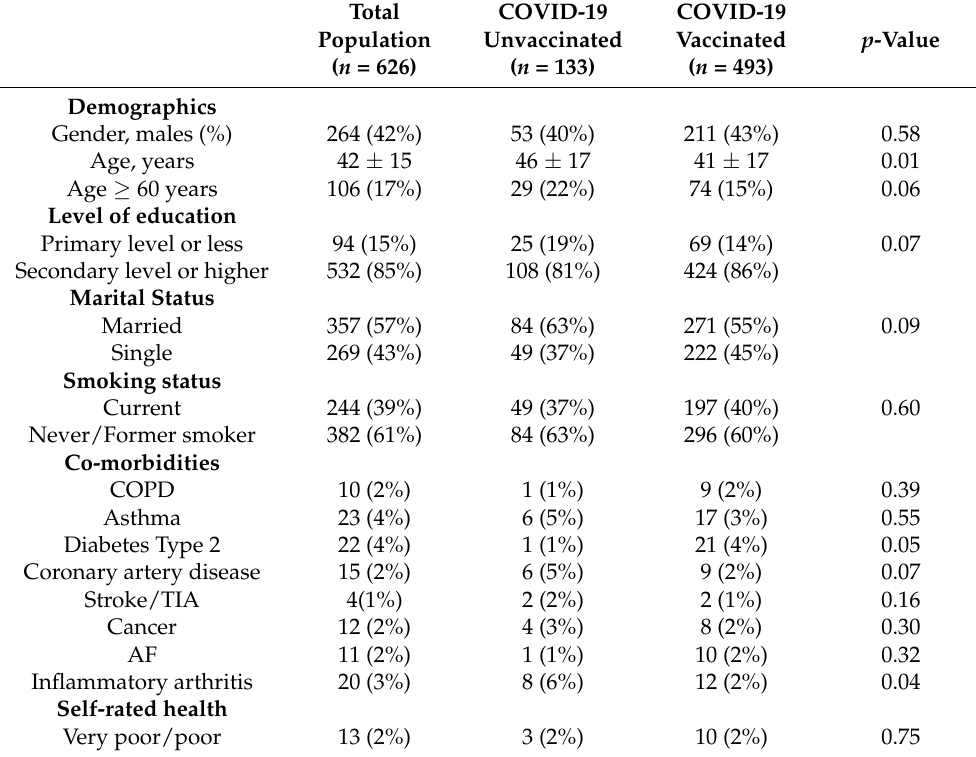
Table 1. Characteristics of the 626 participants.